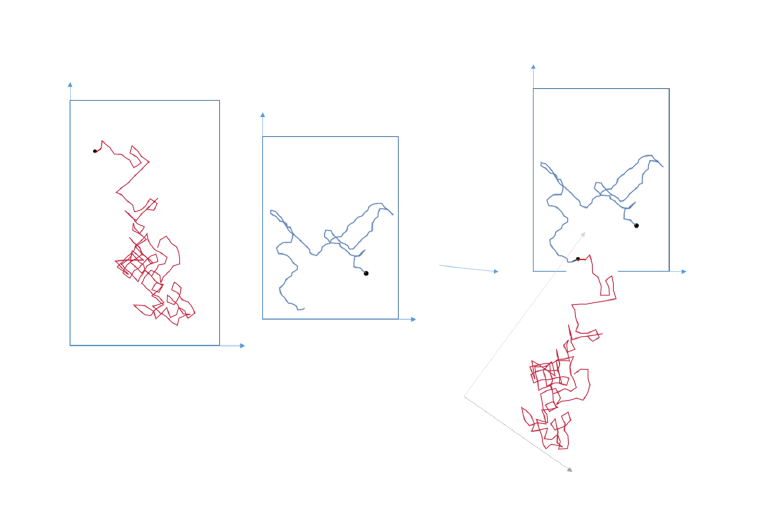
Figure 8. Two patches of pure bimodal trajectories with the different parameters b = − 0.97, d = 0, on the left, b = − 0.877, d = 0, on the right, which compose the mixed bimodal trajectory on the right, with a rotation of 20 o between